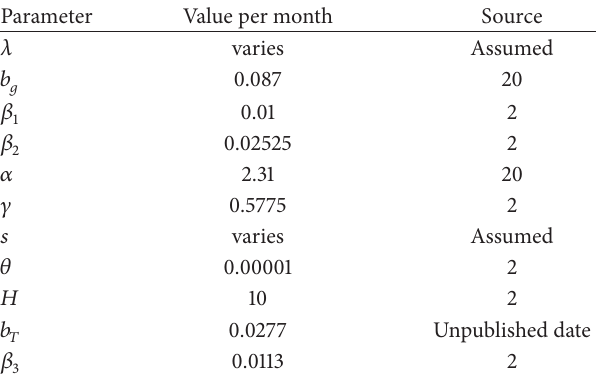
Table 1: Parameter values used in the simulations shown in